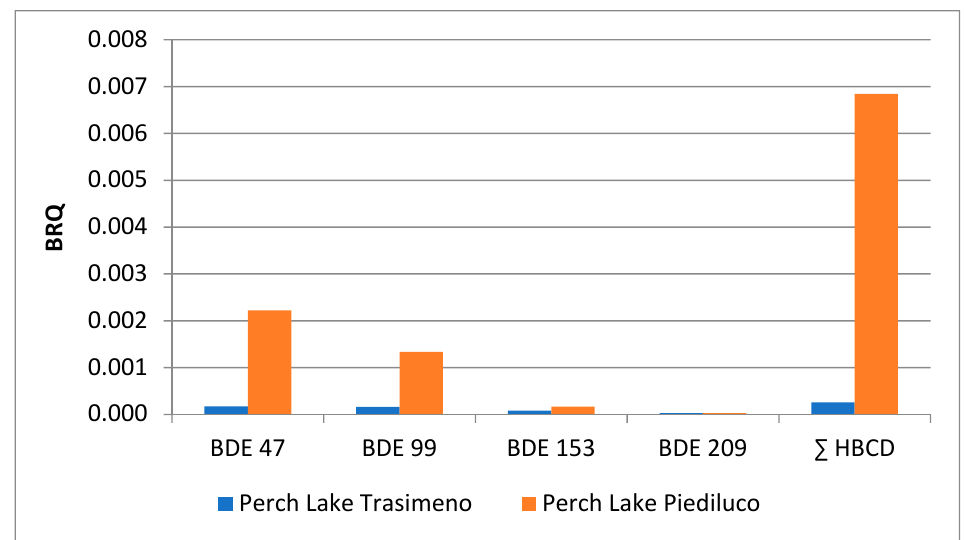
Figure 4. Comparison between BRQ values from perch samples from Trasimeno and Piediluco lakes.